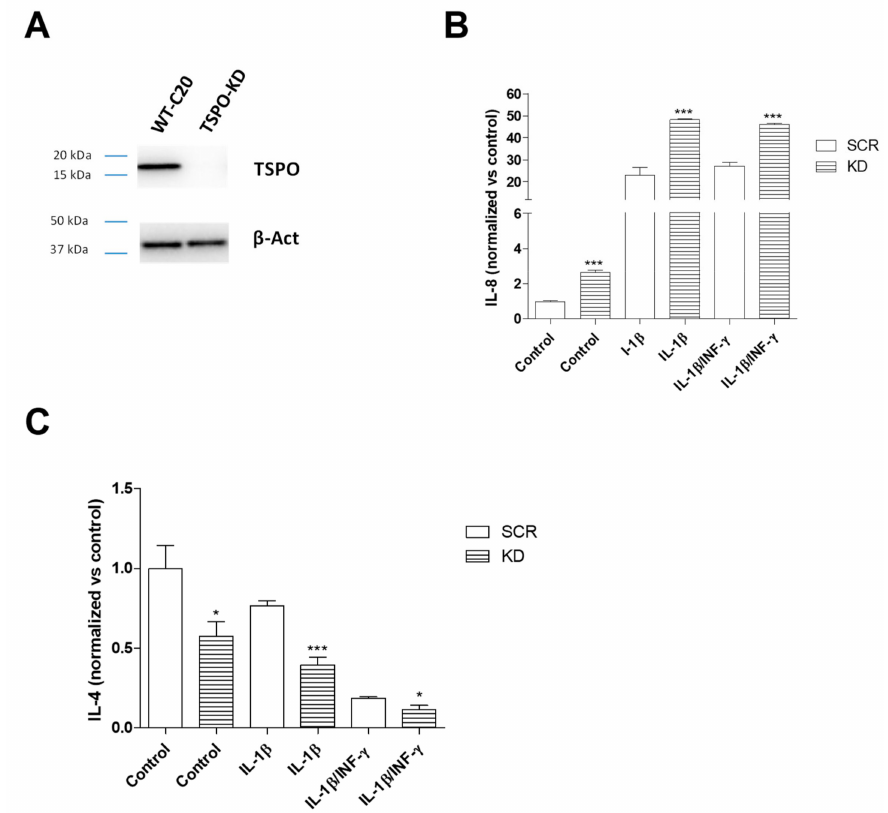
Figure 5. E ff ects of TSPO knockdown (KD) on interleukin release. ( A ) Representative images of TSPO and β -actin expression on SCR and TSPO KD C20 cells by Western blot analysis. SCR and TSPO KD C20 cells were treated with IL-1 β (20 ng / mL) or IL1- β / INF- γ (100 ng / mL / 50 ng / mL) for 24 h in serum-free medium and pro-inflammatory IL-8 ( B ) and anti-inflammatory IL-4 level ( C ) were evaluated. The concentration of IL-8 and IL-4 released in the medium was normalized to the number of cells in each well and expressed as fg / mL / #cells. The bars represent the mean ± SEM of two di ff erent experiments performed in triplicate. The significance of the di ff erences was determined by one-way ANOVA, which was followed by Bonferroni’s post-test: * p ≤ 0.05, ** p ≤ 0.01, *** p ≤ 0.001, respective WT C20 cell treatment. The comparison between the WT C20 cells and SRC C20 cells samples did not show any significant di ff erence, both in the presence and in the absence of inflammatory